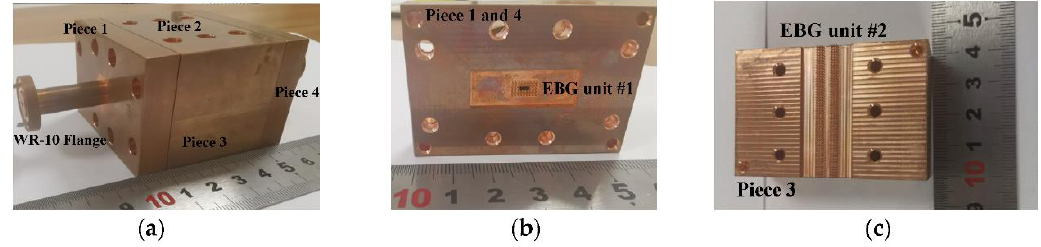
Figure 12. Photographs of the proposed transition prototype. ( a ) Overall appearance of the fabricated prototype; ( b ) Pieces 1 and 4 with EBG unit #1; ( c ) Piece 3 with EBG unit #2.